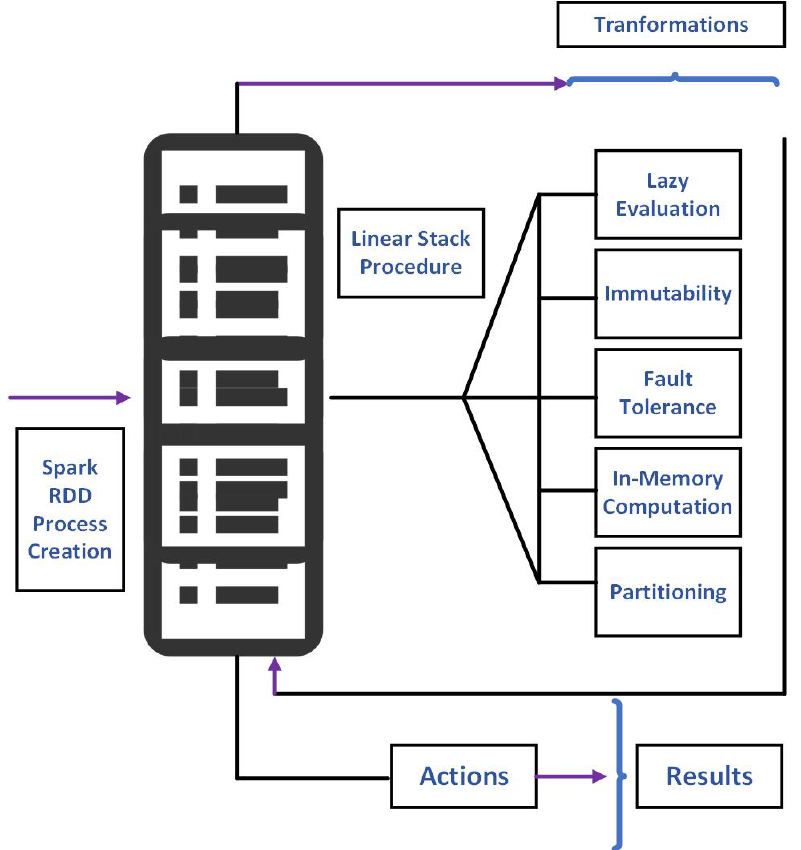
Figure 1. Spark-RDD